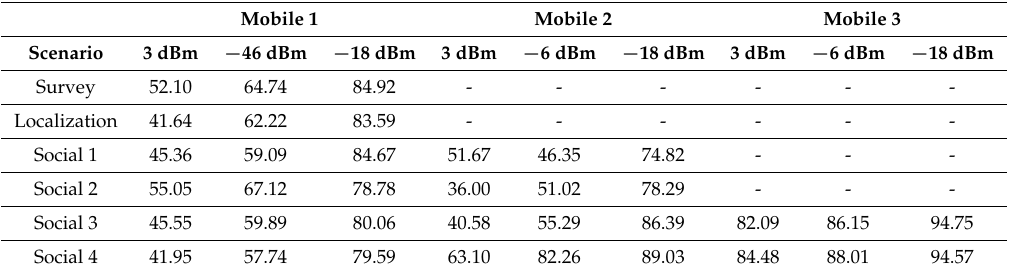
Table 5. Packet loss rate experimented by smart phones.